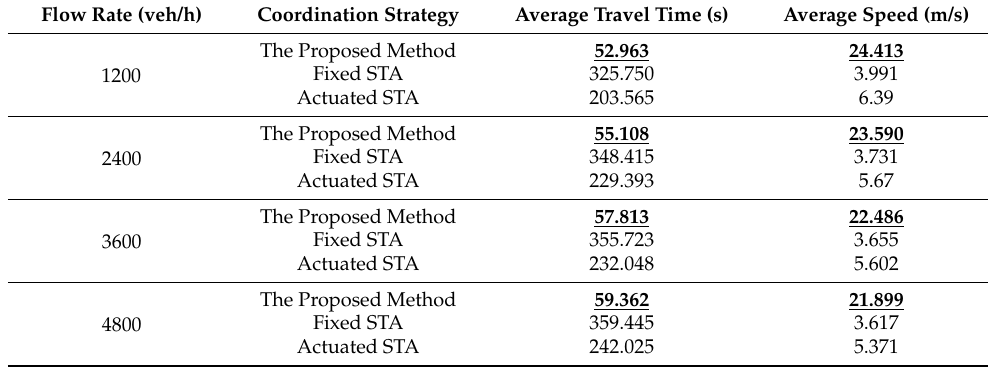
Table 2. Comparison results of different strategies in MiRN under different flow rates.